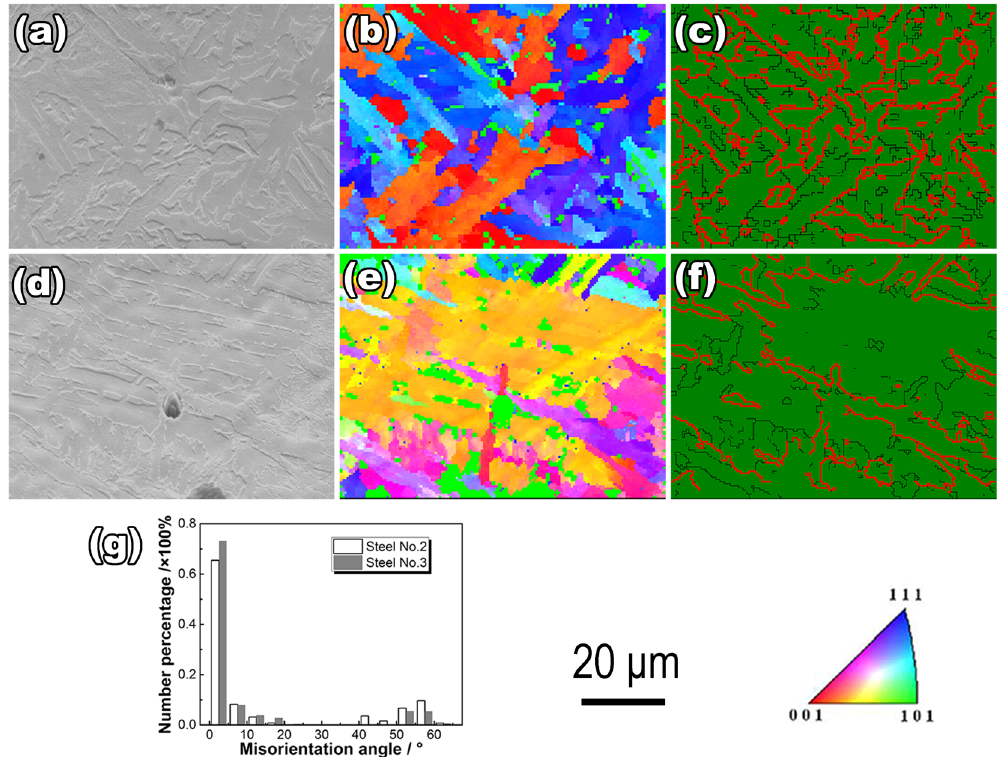
Figure 5: SEM – EBSD results of different microstructures in two steels. ( a and d ) Morphology of the microstructures, ( b and e ) orientation distribution of ferrite grains, ( c and f ) grain boundary angle distribution of ferrite laths in steel no. 2 and 3 correspondingly, and ( g ) difference in grain orientation distribution of ferrite